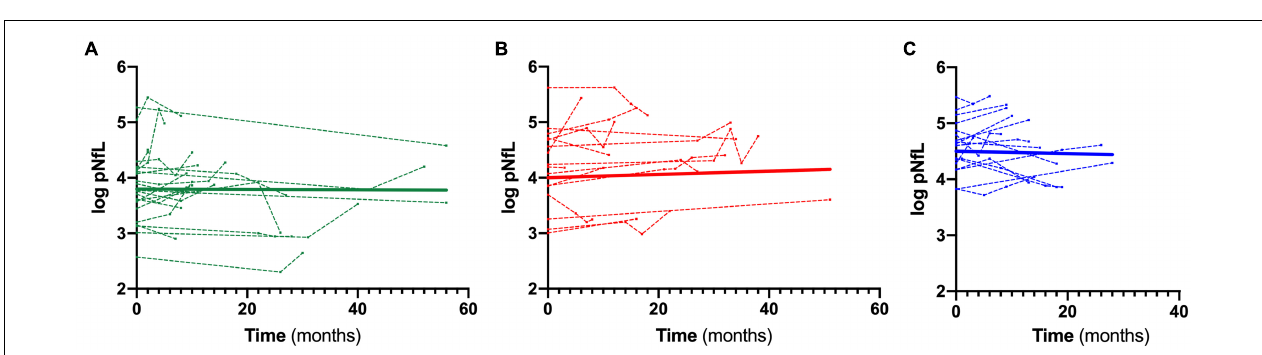
FIGURE 2 | Prognostic value of pNfL and cNfL. Survival curves in ALS patients according to the values of pNfL (A) and cNfL (B) . A greater increase in baseline cNfL and pNfL levels is associated with shorter survival in patients with ALS. Key: c-NfL, cerebrospinal fluid neurofilament light chain; pNfL, plasma neurofilament light chain.